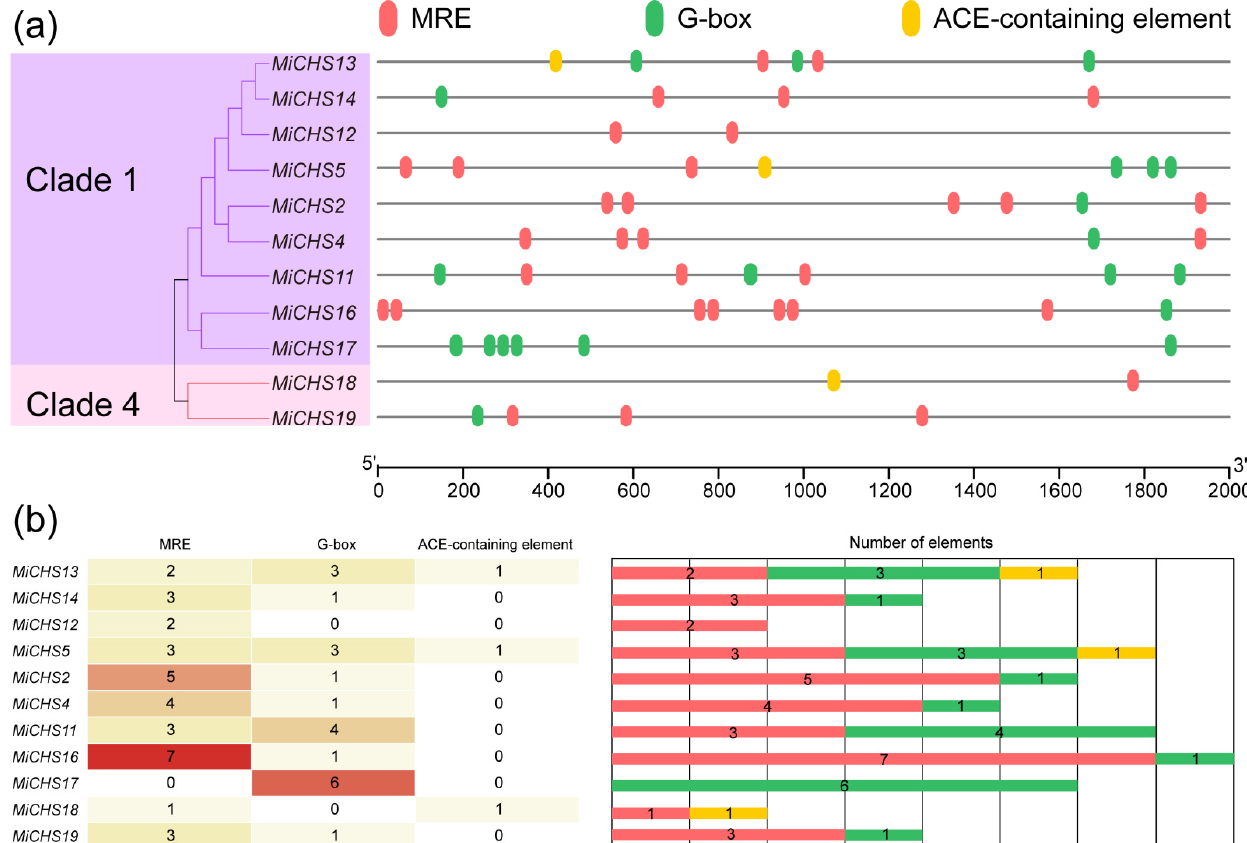
Figure 8. Analysis of light-responsive cis-acting elements in the promoter region of the 11 MiCHS . ( a ) The distribution of light-responsive cis-regulatory elements in the 2 kb upstream sequences of 11 MiCHS genes were analyzed using PlantCARE. ( b ) The statistics of light-responsive cis-regulatory elements for 11 MiCHS genes.